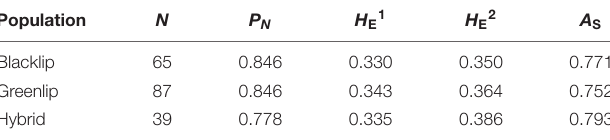
TABLE 1 | Population